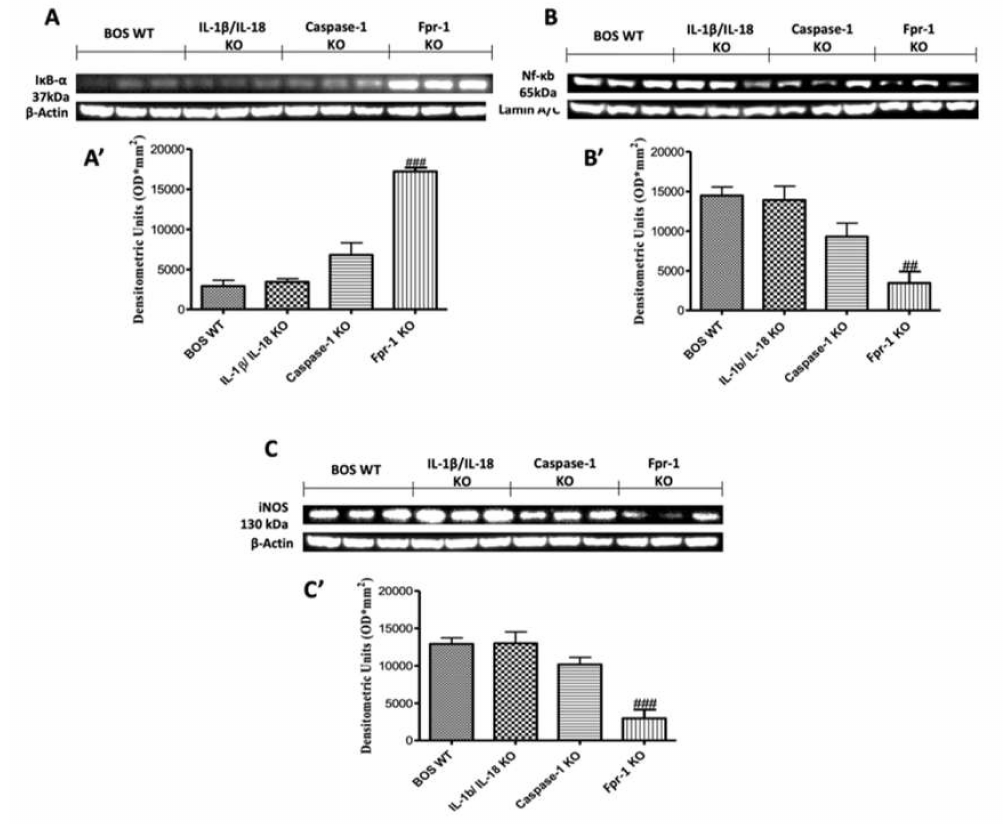
Figure 3. E ff ects of the absence of IL-1 β / IL-18, Casp-1, and Fpr-1 on the NF- κ B pathway and iNOS expression. Western blots and, respectively, the densitometric analysis of IkB- α ( A , A’ ), NF-kB p65 ( B , B’ ), and iNOS ( C , C’ ). For Western blot analyses, n = 5 animals from each group were employed. A p -value less than 0.05 was considered significant. ## p < 0.01 versus the WT group, and ### p < 0.001 versus the WT